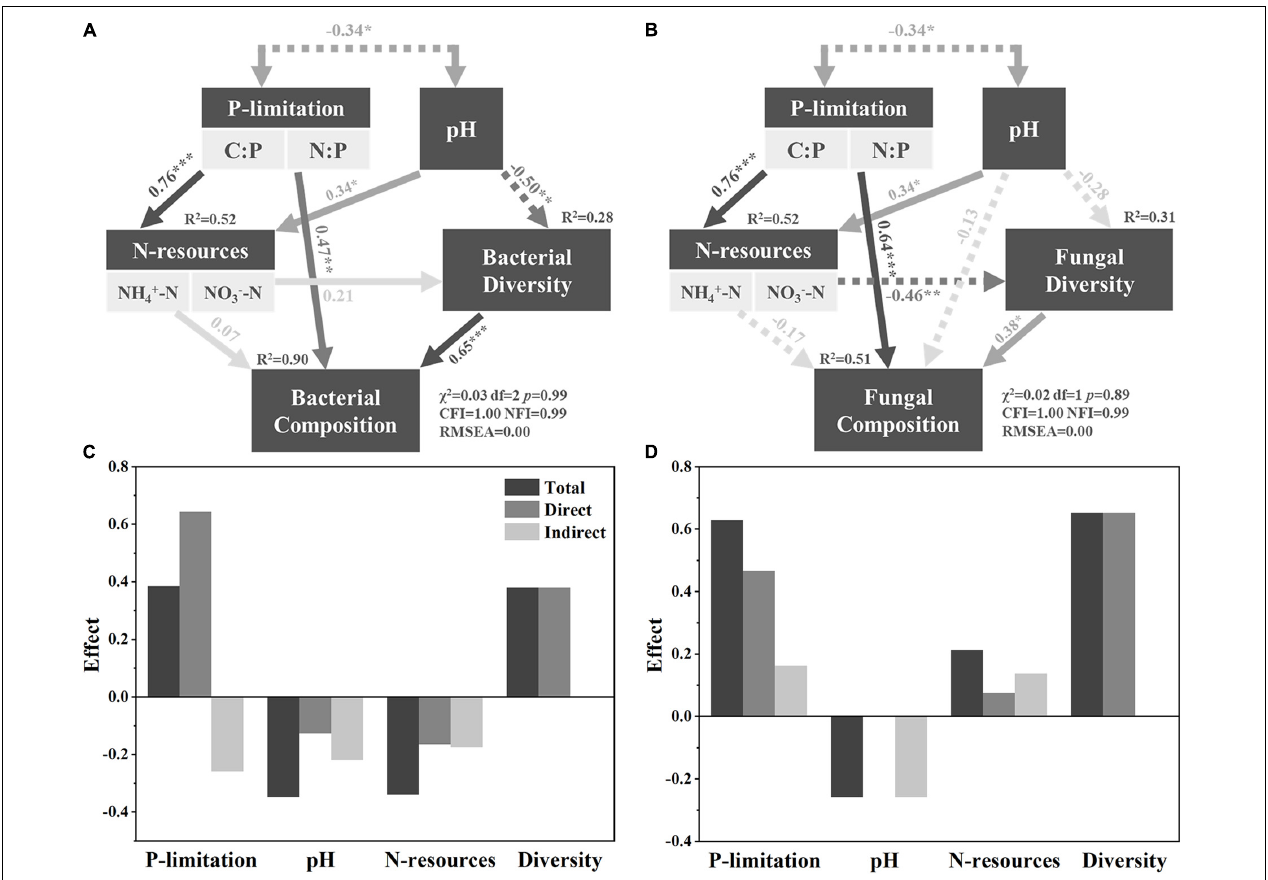
FIGURE 2 | SEM resolving bacterial composition and fungal composition. Panels (A,B) are detailed SEMs for bacterial and fungal composition, respectively, while panels (C,D) show the effects of different factors on composition accordingly. Solid and dashed lines indicate positive and negative correlations, respectively. *, **, and *** indicate significant correlated under p < 0.05, p < 0.01, and p < 0.001,